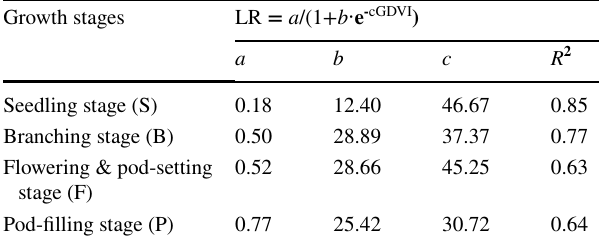
Table 8 Fitting results of Sigmoid functions across four soybean growth stages in the Huaibei Plain study area in Anhui Province, China Growth stages